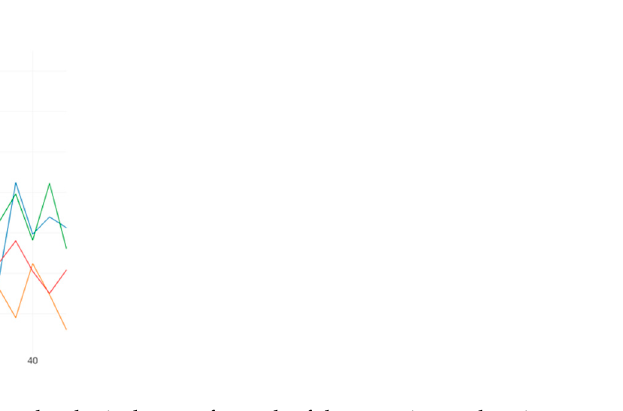
Figure 21. The dynamics of DO concentration in technological water for each of the experimental variants.